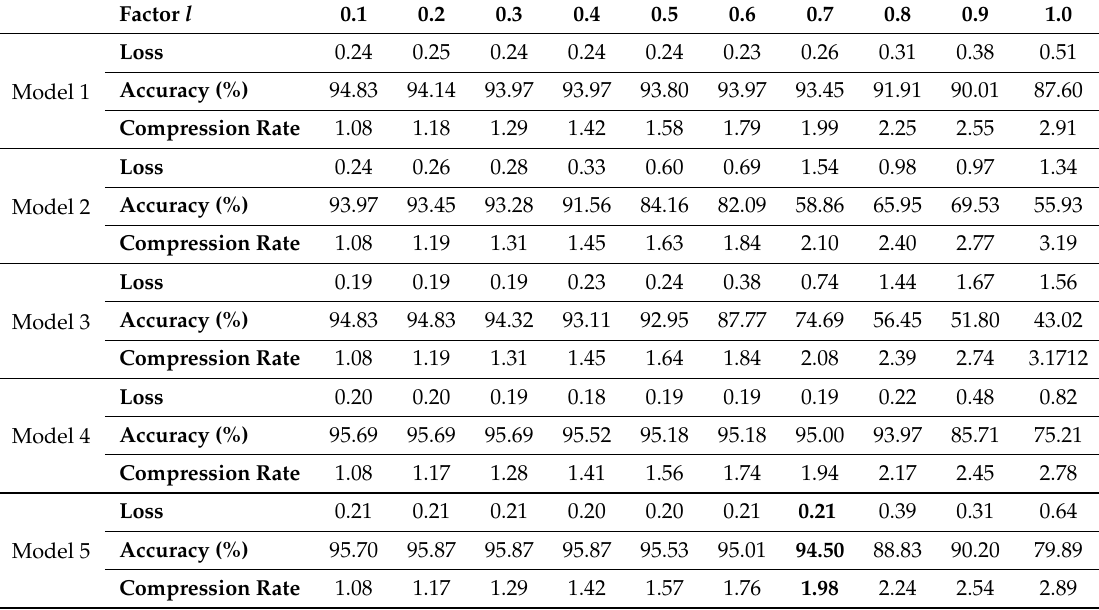
Table 4. Evaluation of the performance for the developed architectures with the method of pruning scalar weights without retraining. Factor l corresponds to the percentage of the standard deviation used to determine the threshold for pruning.